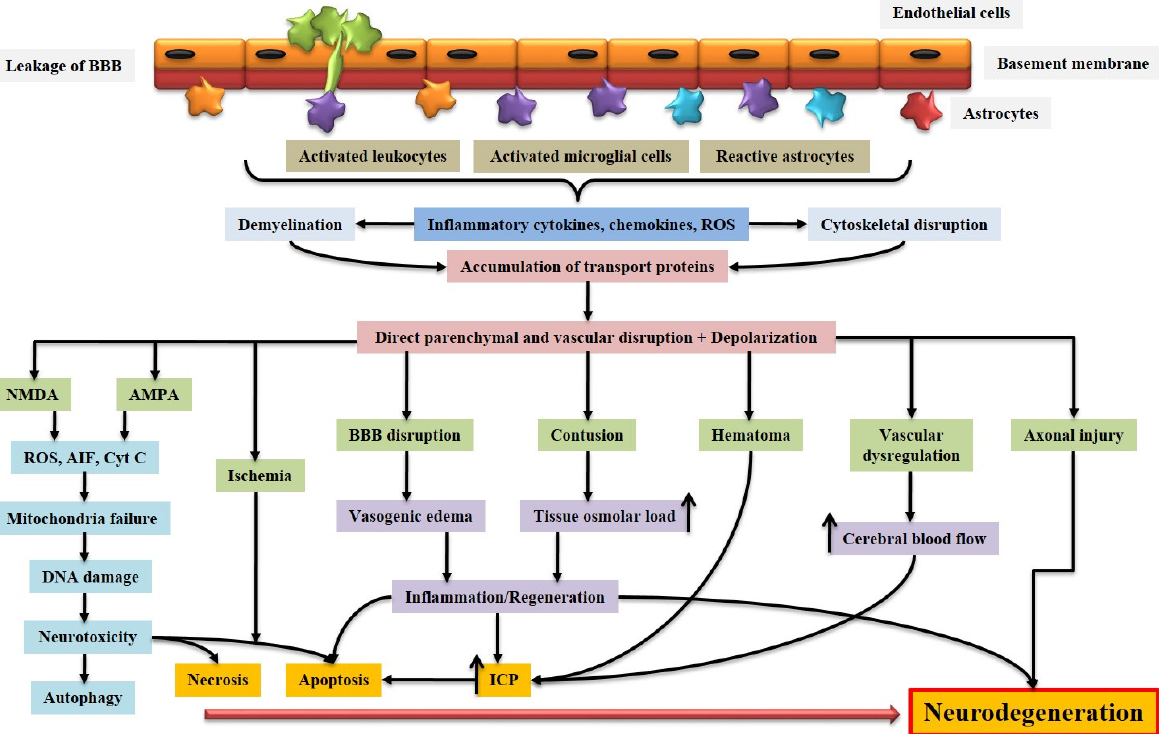
Figure 3. Schematic representation of pathophysiology of ABI. BBB dysfunction caused by injury allows the transmigration of activated leukocytes into the injured brain parenchyma, which is facilitated by the upregulation of cell adhesion molecules. Activated leukocytes, microglia, and astrocytes produce ROS and inflammatory molecules such as cytokines and chemokines that contribute to demyelination and disruption of the axonal cytoskeleton, leading to axonal swelling and accumulation of transport proteins at the terminals. On the other hand, excessive accumulation of glutamate and aspartate neurotransmitters in the synaptic space due to spillage from severed neurons activates NMDA and AMDA receptors located on post-synaptic membranes, which allow the production of ROS. As a result of mitochondrial dysfunction, molecules such as apoptosis-inducing factor (AIF) and cytochrome c are released into the cytosol. These cellular and molecular events including the interaction of Fas with its ligand Fas ligand (FasL) ultimately lead to caspase-dependent and -independent neuronal cell death. BBB: blood-brain barrier; NMDA: N-methyl-D-aspartate receptor; AMPA: α -amino-3-hydroxy-5-methyl-4-isoxazole propionic acid receptor; ROS: Reactive oxygen species; Cyt c: Cytochrome c; ICP: Intracranial pressure; AIF: Apoptosis-inducing factor.